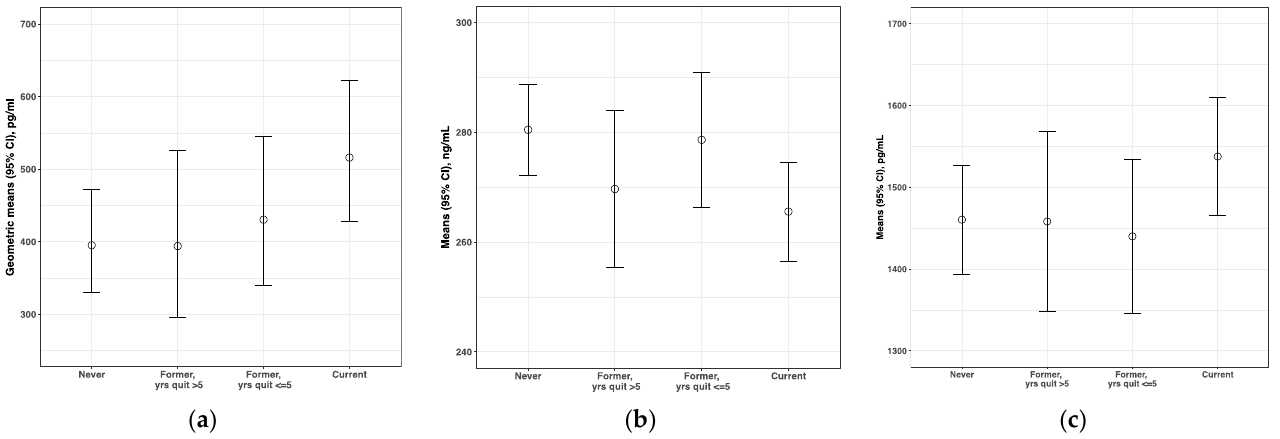
Figure 2. Associations between smoking status and biomarker levels: ( a ) CCL17/TARC ( P trend = 0.01); ( b ) sgp130 ( P trend = 0.01); ( c ) BAFF ( P trend = 0.08). Smoking status and years since quit were self-reported; however, twin pairs with discordance in self-reports and serum cotinine levels were excluded from analysis. Points represent means (BAFF and sgp130) or geometric means (CCL17/TARC) of biomarker levels and solid lines represent 95% confidence interval (CI).